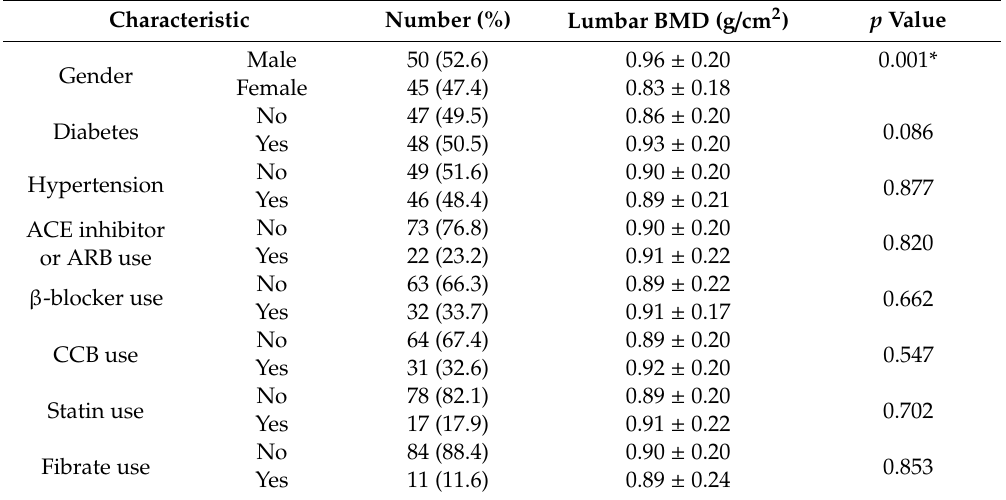
Table 2. Clinical characteristics and lumbar bone mineral density levels of the 95 hemodialysis